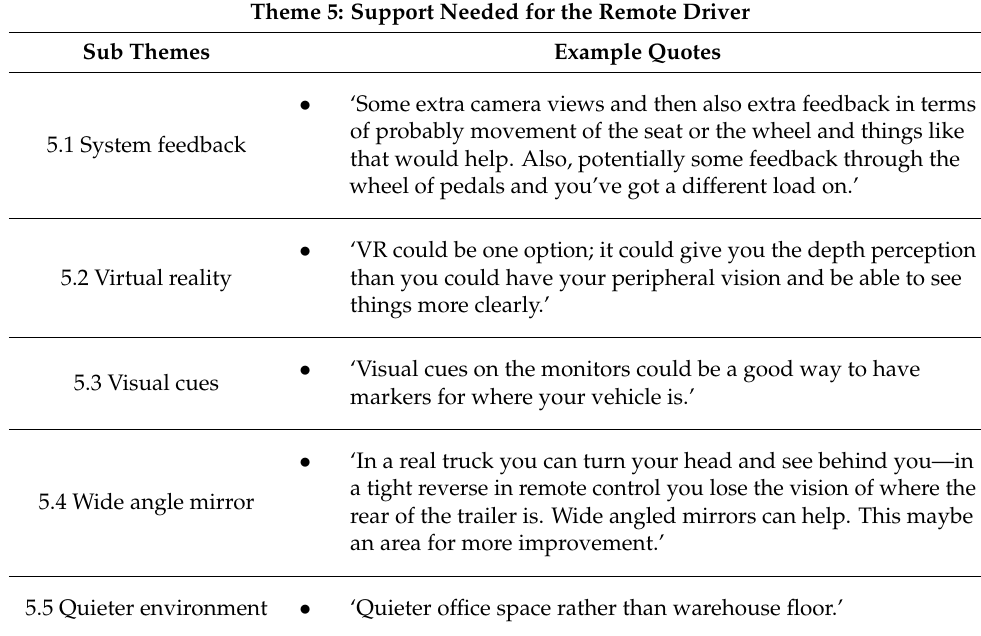
Table 5. Theme 5: Support needed for the remote